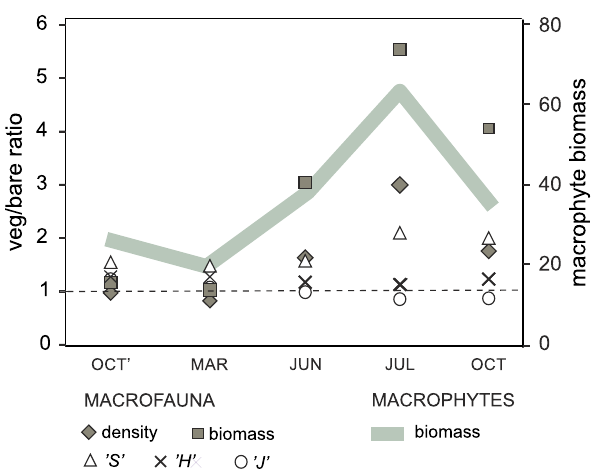
Figure 4. Magnitude of difference in macrofauna univariate characteristics between two bottom types plotted against total macrophyte biomass [g dw m 2 2 ]. Veg/bare ratio - ratio of mean recorded on vegetated bottom to mean on bare sand, for samples collected in 5 months (OCT’- October 2010, MAR - March 2011, JUN - June 2011, JUL - July 2011, OCT - October 2011). Veg/bare ratio presented for density, biomass, number of species per sample ( ‘S’ ), Shannon-Wiener index ( ‘H’ ), Pielou index ( ‘J’ ).